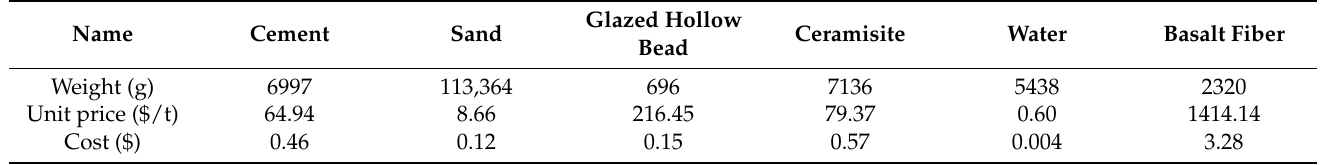
Table 9. Raw materials and costs per square meter of insulating concrete.